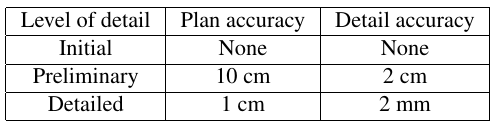
Table 1. Required levels of accuracy for each level of documentation detail. Adapted from (Letellier,